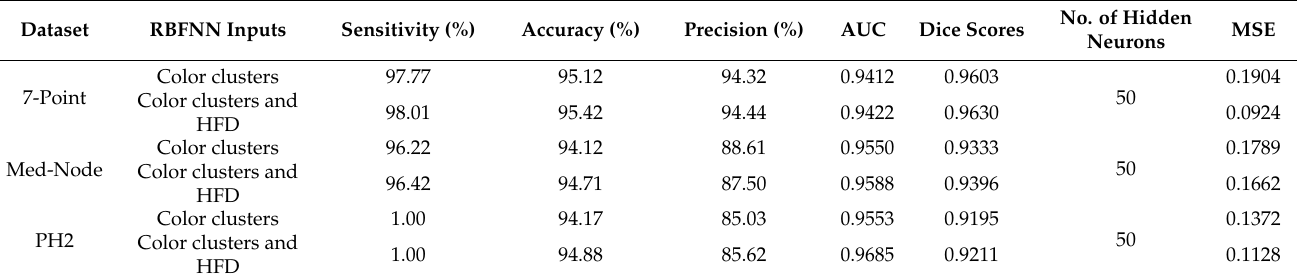
Table 3. Performance of the RBFNN classifier in the testing